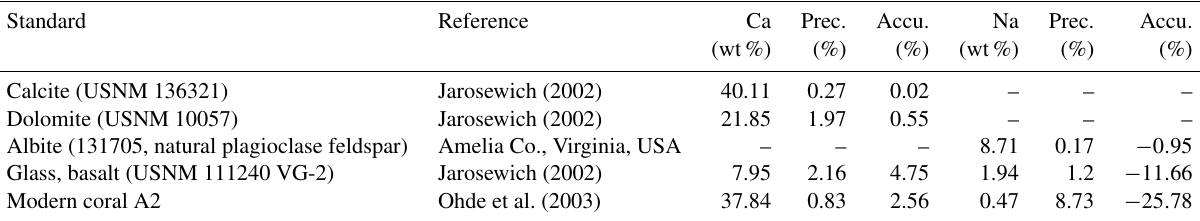
Figure 3. Box and whisker plots of the range and distribution of Na / Ca in newly grown test chambers of T. sacculifer during culture experiments. The boxes include all data within the first and third quartile. The horizontal solid line in the center of each box demonstrates the mean and the dashed line represents the median. Minimum and maximum values are marked by vertical lines (whiskers). Color coding is similar to Figs. 4 and 5. (a) Na / Ca within test chambers grown at varying salinities (26–45) and constant temperature (26.5 ◦ C ± 0.25 ◦ C). Datasets for T = 26 . 5 ◦ C of both temperature experiments ( S 36, S 33) were added (Tables 4, 5). Number of electron microprobe maps for each experiment from lowest to highest salinity: n = 20, 29, 26, 34, 24, 12. The black-colored box shows results of the 44 salinity experiment, in which cultured foraminifera underwent gametogenesis (Nürnberg et al., 1996) and were therefore excluded from the regression in Fig. 4. (b) Na / Ca within test chambers grown at varying temperatures (19.5–29.5 ◦ C) in two salinity groups at either a constant salinity of 33 ( S 33) or 36 ( S 36). Number of electron microprobe maps for each experiment from lowest to highest temperatures: n ( S 33) = 26, 31, 29, 29; n ( S 36) = 26, 24, 26, 24. Table 2. Reference materials used for electron microprobe analysis. Precision (Prec.) and accuracy (Accu.) are expressed as the relative standard deviation (RSD) and the relative error in percent. Measurements were performed with 10µm × 10µm maps (number of pixels: n =